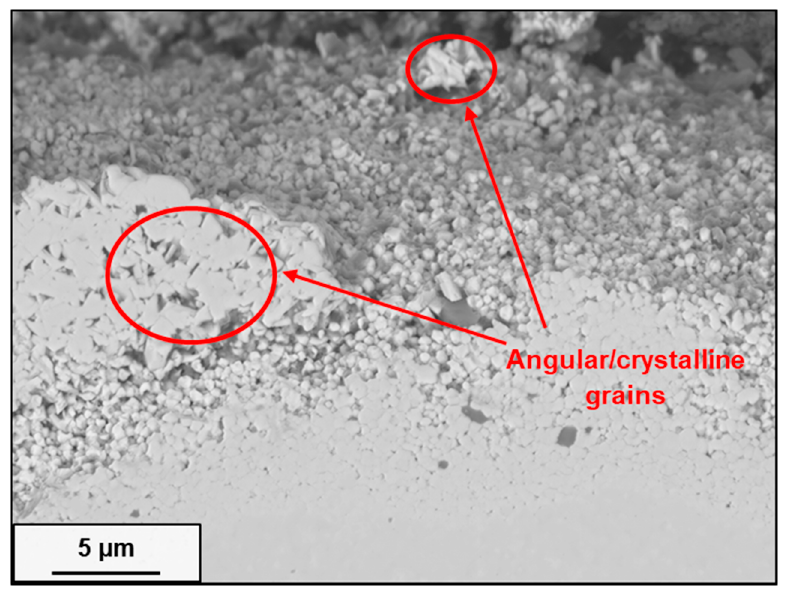
Figure 6. SEM images of the cross section of ZrO 2 sample after molten salt exposure.